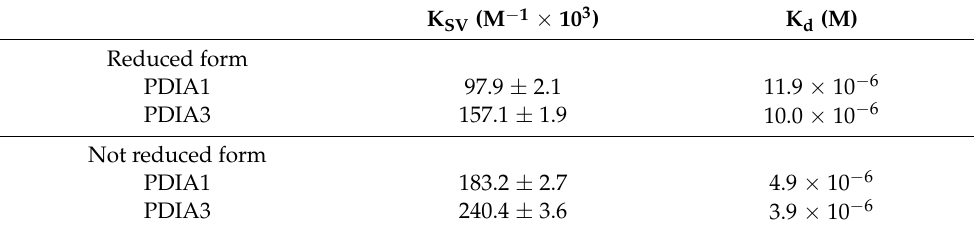
Table 1. Stern–Volmer constants (K SV ) and dissociation constant (K d ) obtained by fluorescence quenching analysis of PDIA1 and PDIA3 in the presence of punicalagin. Data were calculated from fluorescence quenching analysis using both proteins (0.1 × 10 − 6 M) in reducing and non-reducing conditions (pH 7.4, 25 °C) and increasing concentration of punicalagin (up to 4 × 10 − 6 M). K SV are reported as mean and SEM of at least three independent experiments.